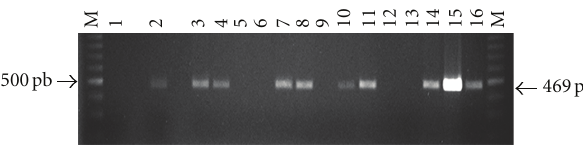
Figure 1: Electrophoresis in 1.8% agarose and ethidium bromide staining of amplified products with primers Tg1 and Tg2 of